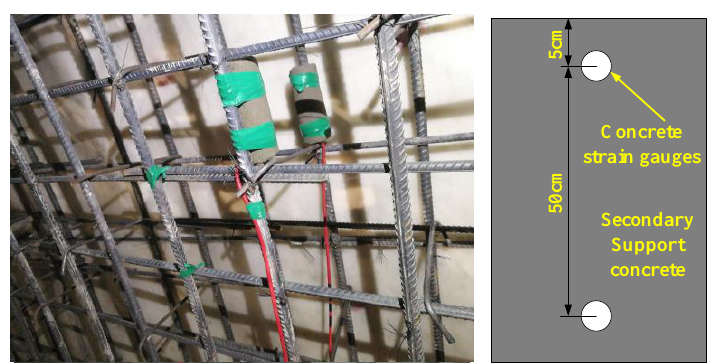
Figure 10. Layout of the concrete strain gauges.